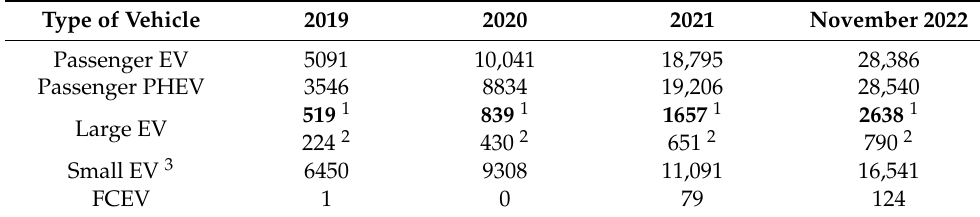
Table 1. Number of registered electric vehicles in Poland in recent years (based on [28]). Type of